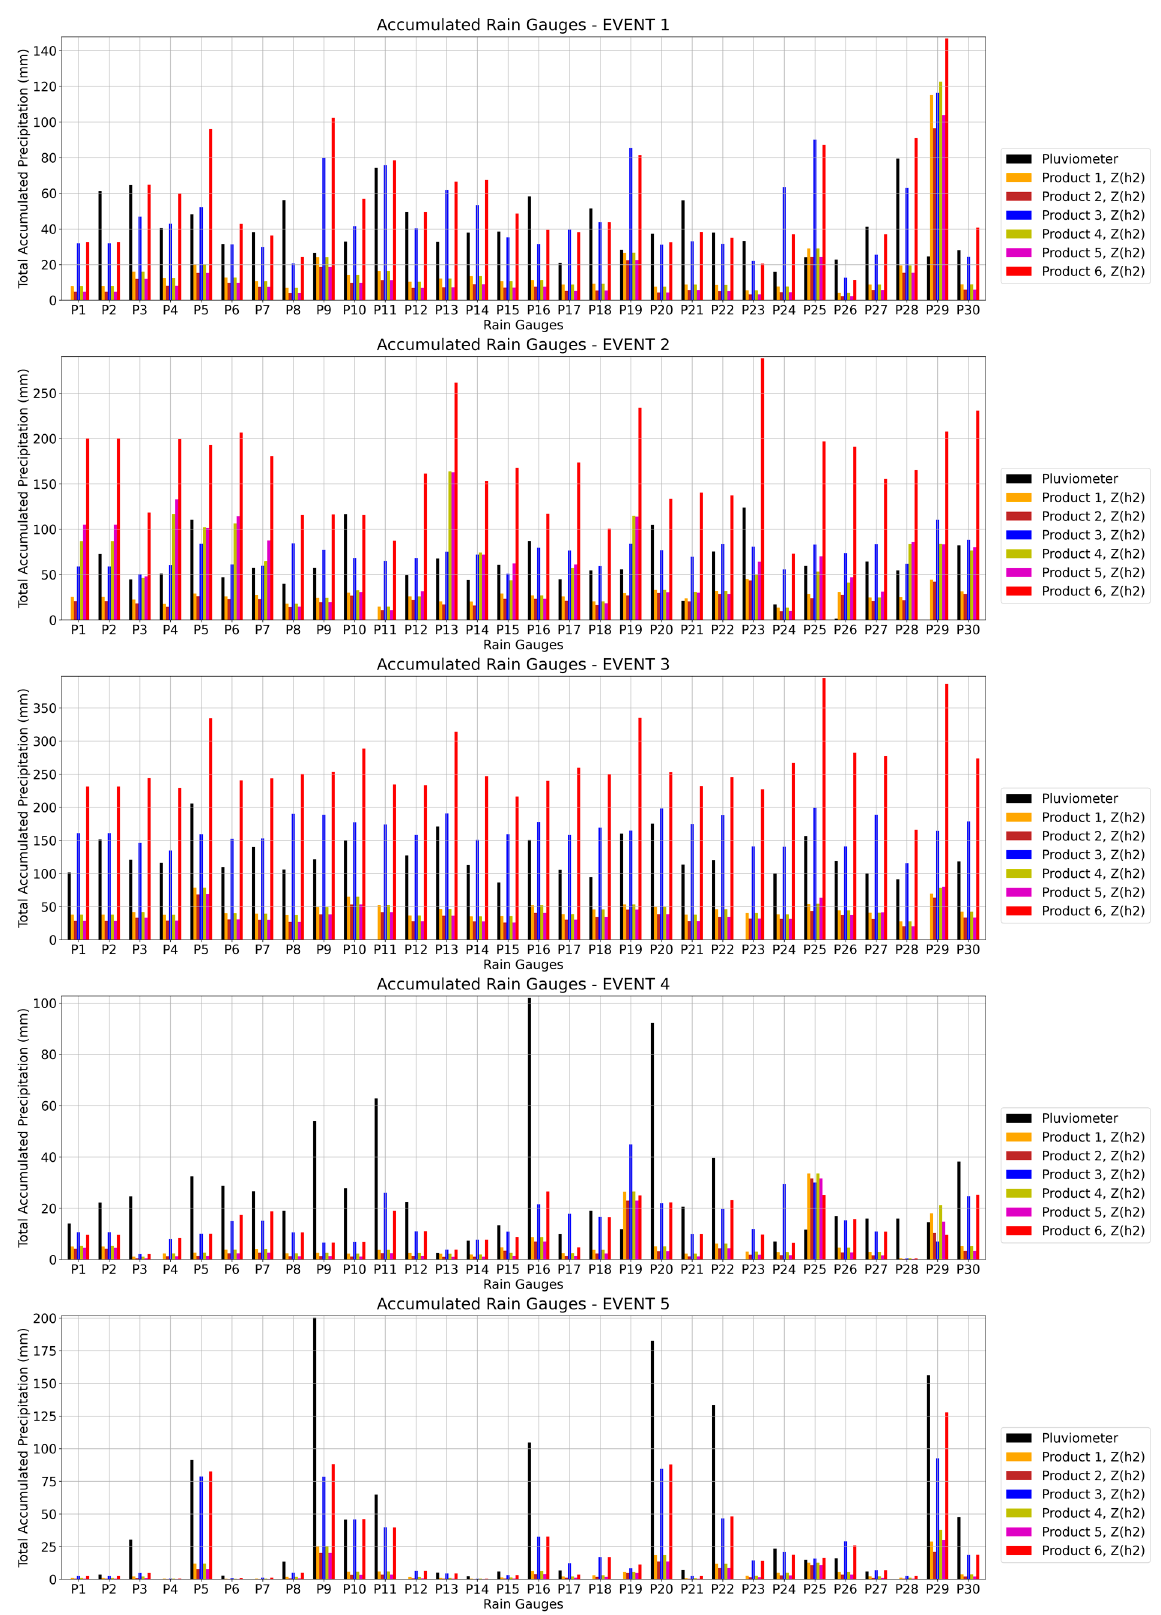
Figure 6. Total accumulated precipitation comparisons for Events 1, 2, 3, 4, and 5 between rain gauge results and Guaratiba’s six S-band radar products using Z h 2 at radar pixels where rain gauges are located.